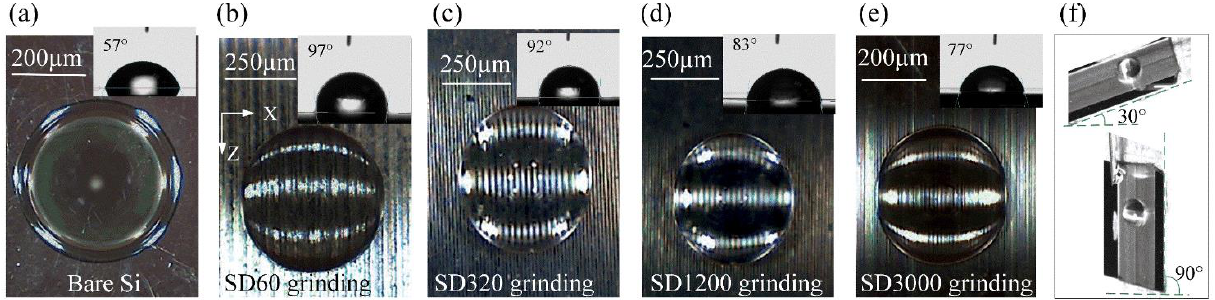
Figure 7. Static wettability states of droplets on the microfabricated BLHS surfaces. The subgraphs are the contact angles of the measured surfaces.